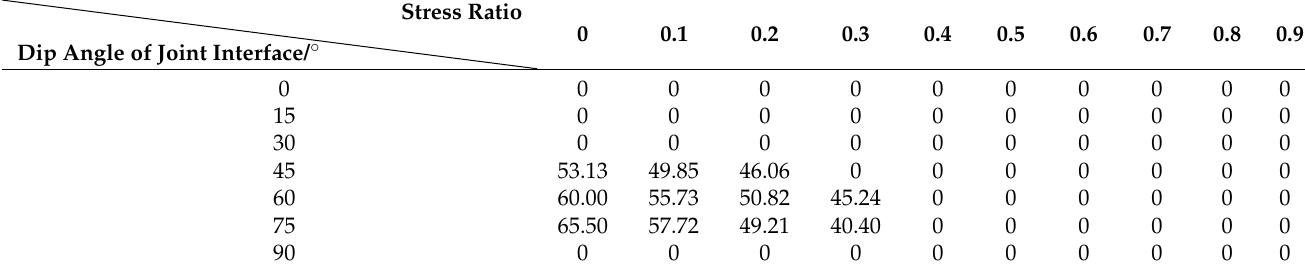
Dip Angle of Joint Interface/ ◦